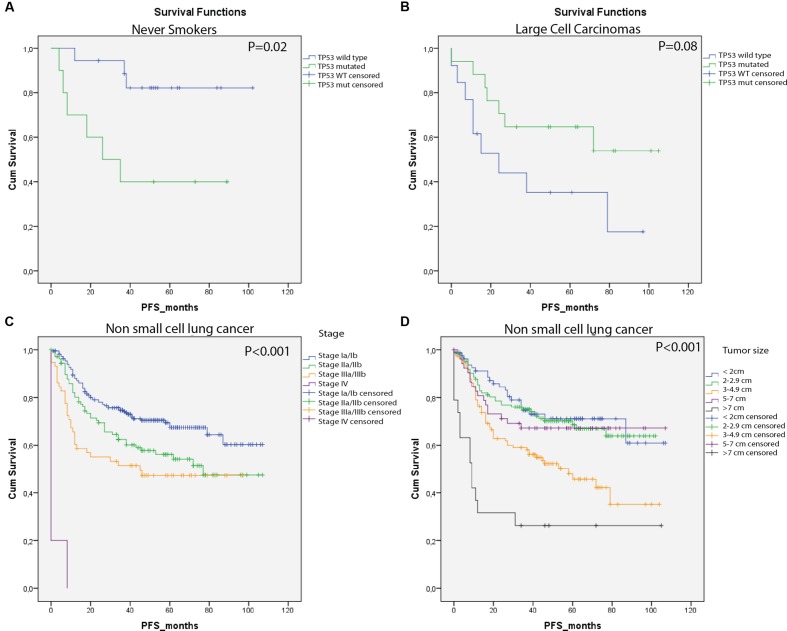
Kaplan–Meyer estimates of PFS for study patients by group. (A) Never-smokers without TP53 mutation showed significant prolonged time to progression. (B) Individuals with TP53 mutated large cells carcinomas showed a beneficial PFS compared with the non-carriers. (C) Stage was significantly associated with PFS. (D) Tumor size was significantly associated with PFS.